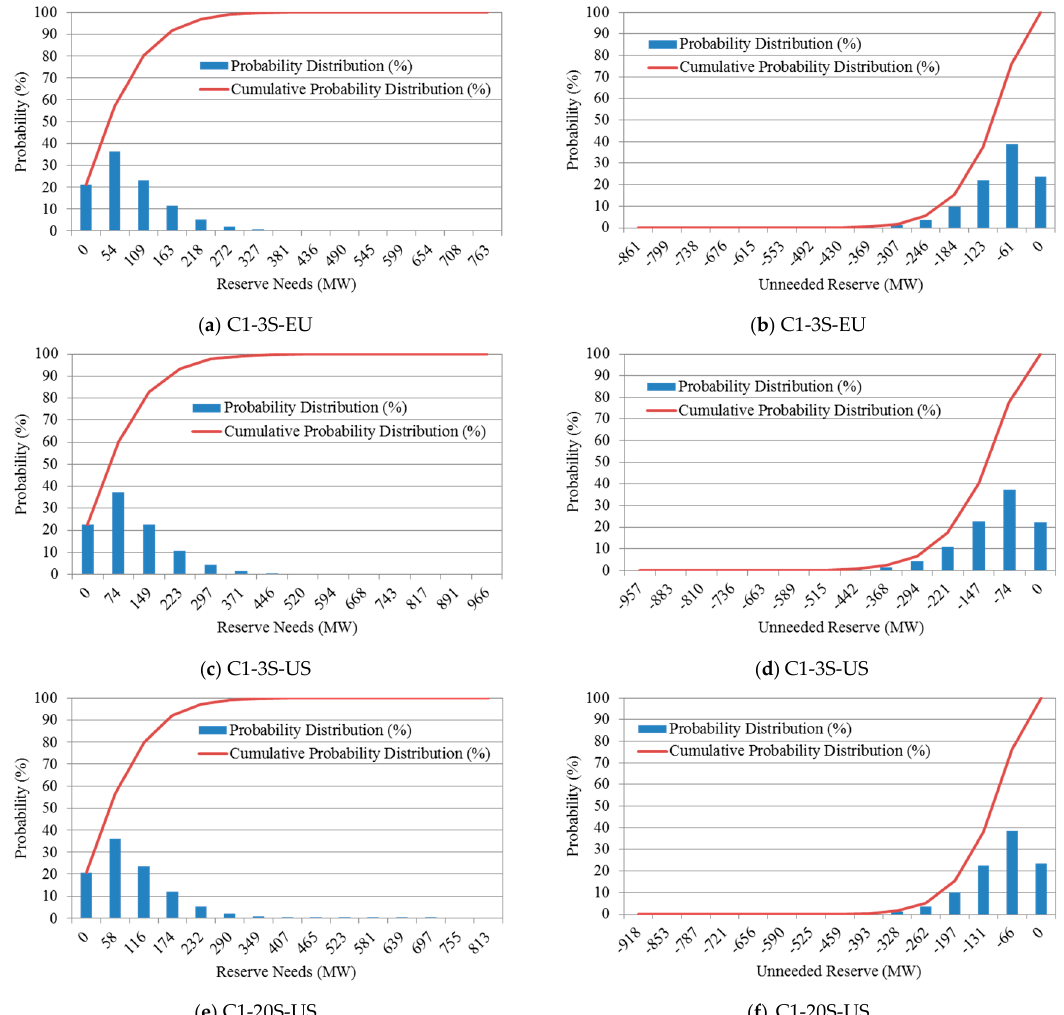
Figure 2. Probability distribution functions of the reserve needs and unneeded reserve. The range of the most probable events in both cases decreases significantly; whereas in C1-3S-US (Figure 3c), the most probable events are inside the interval between {0, 148} MW, in case C1-20S-US (Figure 3e) are inside the interval between {0, 66} MW. This is also reflected in Table 5 through the decrease of the risk indices. Undoubtedly, the relationship between wind farms can effectively bring benefits to wind power